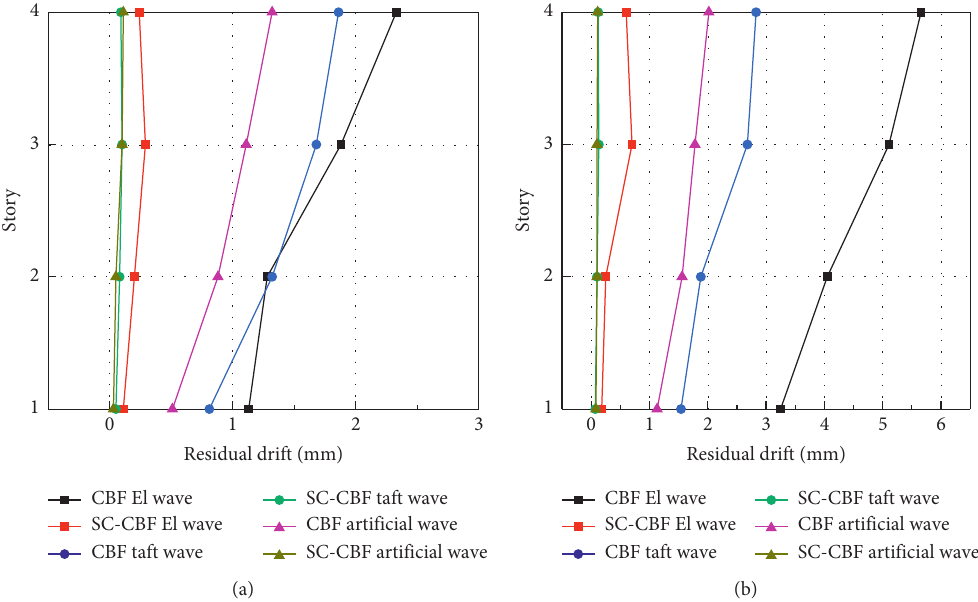
Figure 21: Residual drift response of 4-story structure under earthquake actions: (a) rare earthquake; (b) extremely rare earthquake.